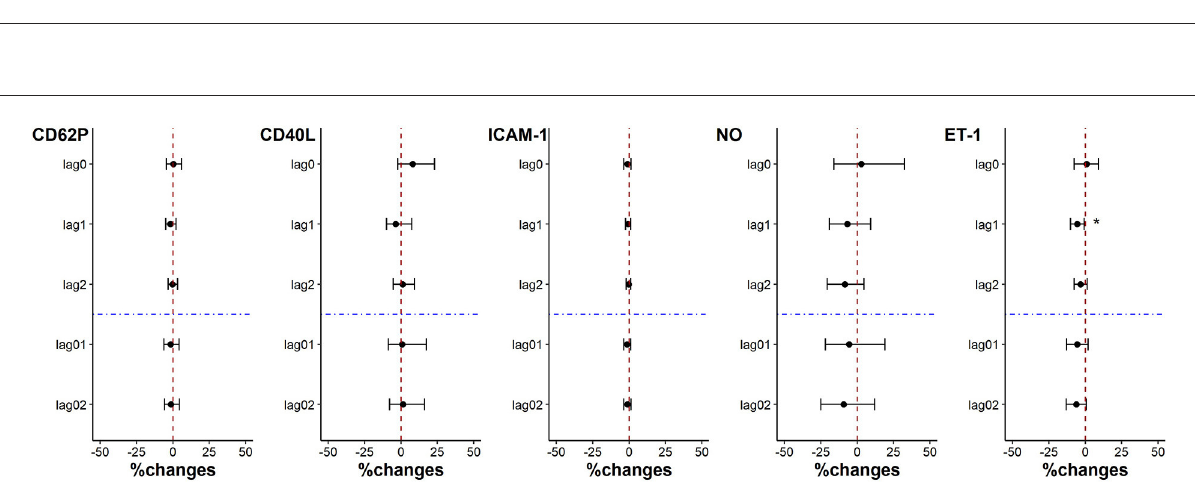
FIGURE3 Percent changes in coagulation indicators associated with an IQR decrease in PM 2.5 exposure. * p <